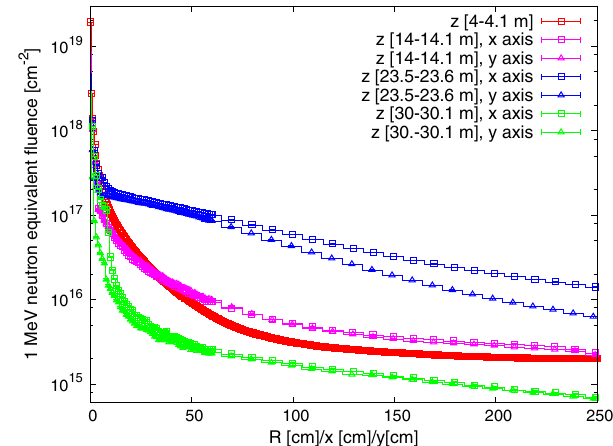
FIG. 10. 1 MeV neutron equivalent fluence after an integrated luminosity of 30 ab − 1 as a function of the distance from the beam line, at different z positions in the detector, as in Fig.